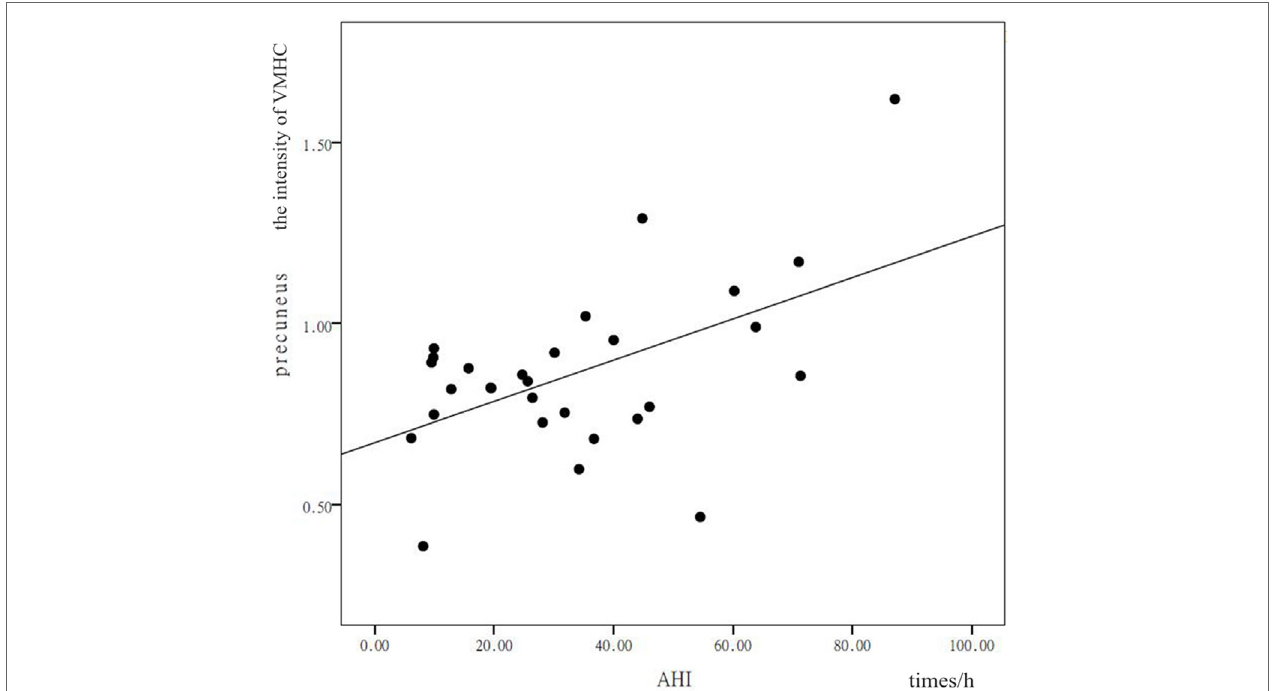
FigUre 3 | Shown is a significant positive correlation between the voxel-mirrored homotopic connectivity (VMHC) values in the precuneus and calcarine cortex, and the apnea–hypopnea index (AHI). X represents the AHI and Y represents the intensity of the VMHC.